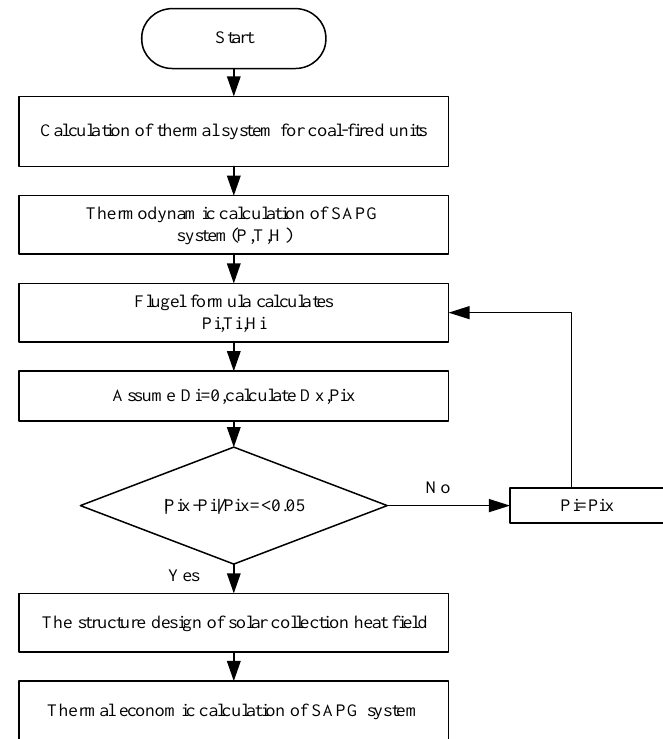
Figure 6. Flow chart of the calculation of the SAPG system.